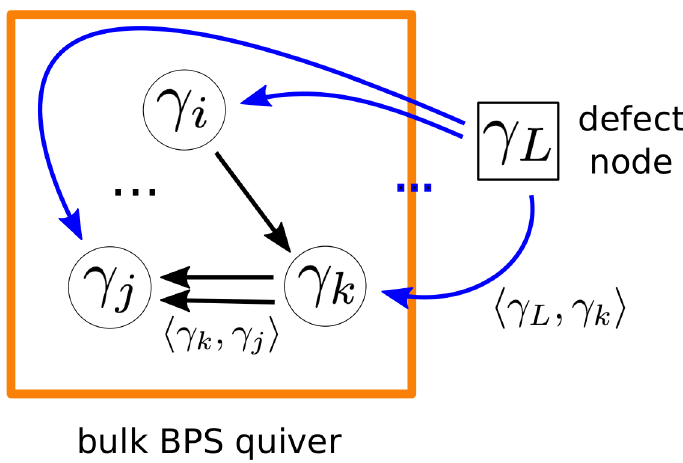
Figure 2 . A framed BPS